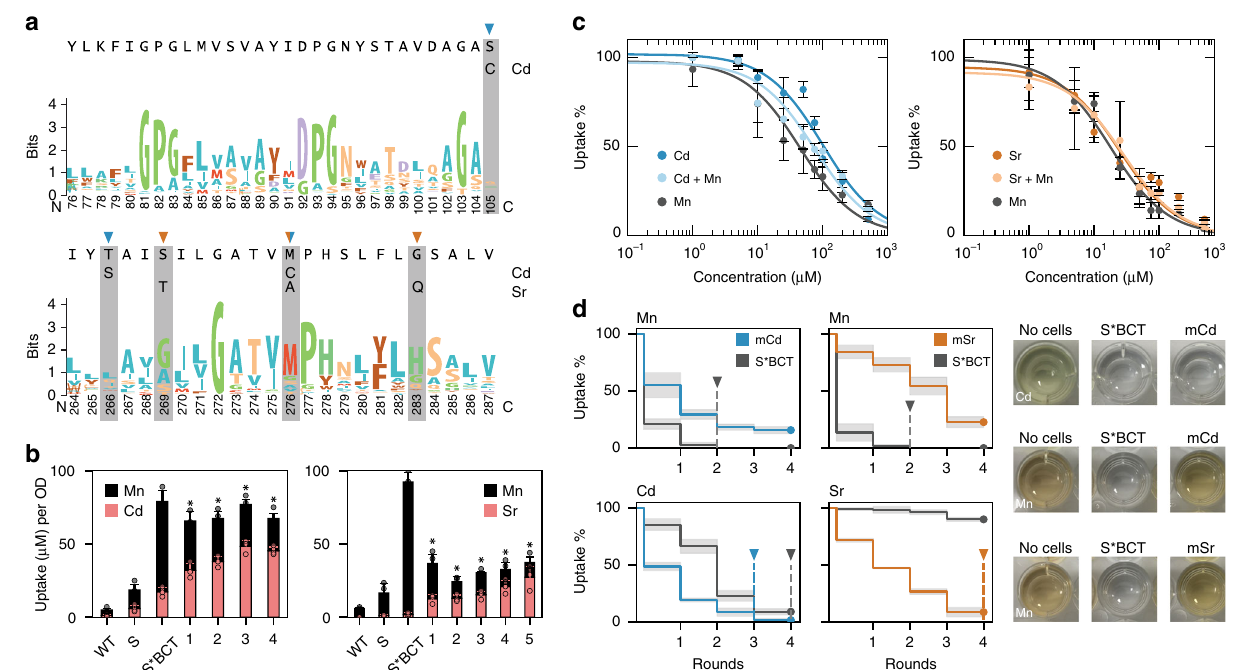
Fig. 5 Creation of a cadmium and strontium metal transporter after 4 – 5 rounds of screens. a Weblogos of SMF1 TM1,6 from Nramp multi-alignment are displayed, with cadmium and strontium mutations highlighted. Cadmium mutants had S105C, T266S, and M276C. Strontium mutants had G189R, S269T, M276A, and G283Q. b Total metal uptake of 100 μ M cadmium and manganese were measured to assess manganese interference. Cadmium mutant labeling corresponds to 1 = M276C, 2 = M276C + S105C, 3 = M276C + T266S, and 4 = M276C + S105C + T266S. Strontium mutant labeling corresponds to 1 = M276A, 2 = M276A + G189R, 3 = M276A + G189R + S269T, 4 = M276A + G189R + G283Q, and 5 = M276A + G189R + S269T + G283Q. Strain background for all mutants were BCT. Asterisk above bar charts represent signi fi cant changes in both Cd and Mn uptake compared to un- mutated S*BCT ( p < 0.05). c Titration curves of fully mutated cadmium and strontium transporters in strain BCT were performed for Cd or Sr, respectively, with or without 100 μ M Mn; x -axis represents the concentration of either Cd, Sr, or Cd, Sr, with Mn. d Sequential uptake experiments, up to 4 rounds, were performed to measure the amount of iterations required for complete elimination of 100 μ M cadmium or strontium in a mixture of 100 μ M manganese. Images on the right are colorimetric detection of cadmium and manganese (there are no available colorimetric assays for strontium at this concentration) showing selective preference for cadmium (no coloration) against native metal manganese (darkened well). For all data, the mean ± s.d. of three replicates are shown. The source data underlying Fig. 5c are provided as a Source Data fi